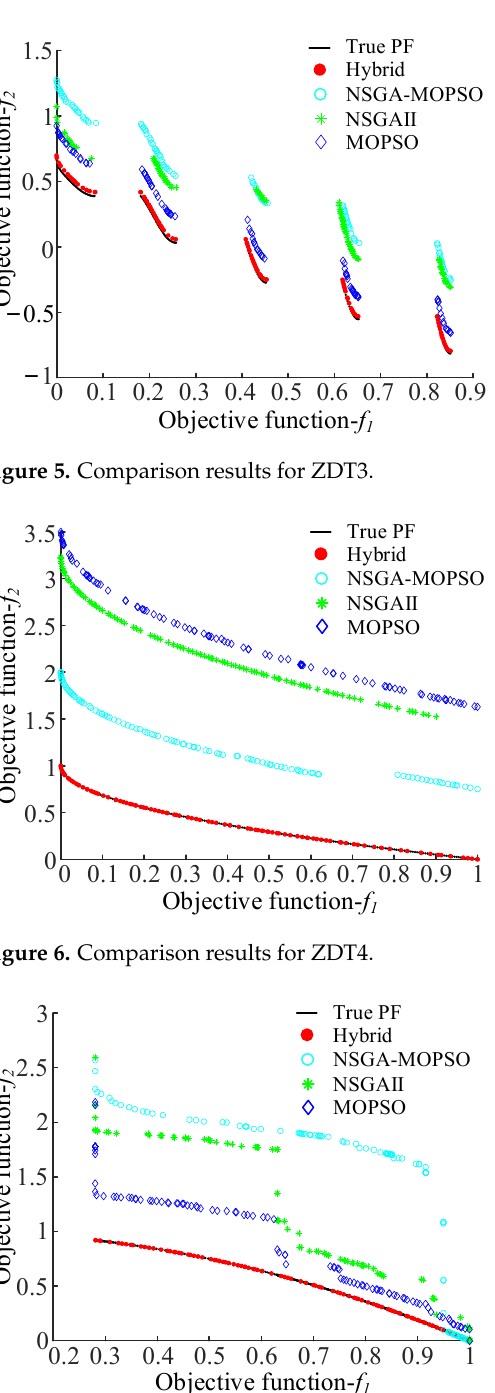
Figure 4. Comparison results for ZDT2.